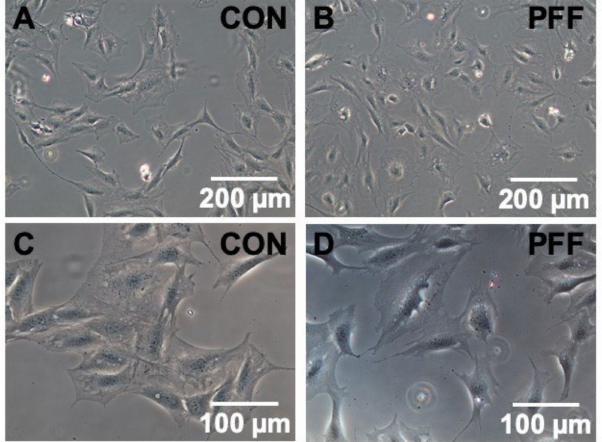
Figure A3. Cell morphology of MC3T3-E1 pre-osteoblasts at 4 h post-incubation without loading, following treatment with or without 1 h PFF. ( A , C ) Static control cells. ( B , D ) 1 h PFF-treated